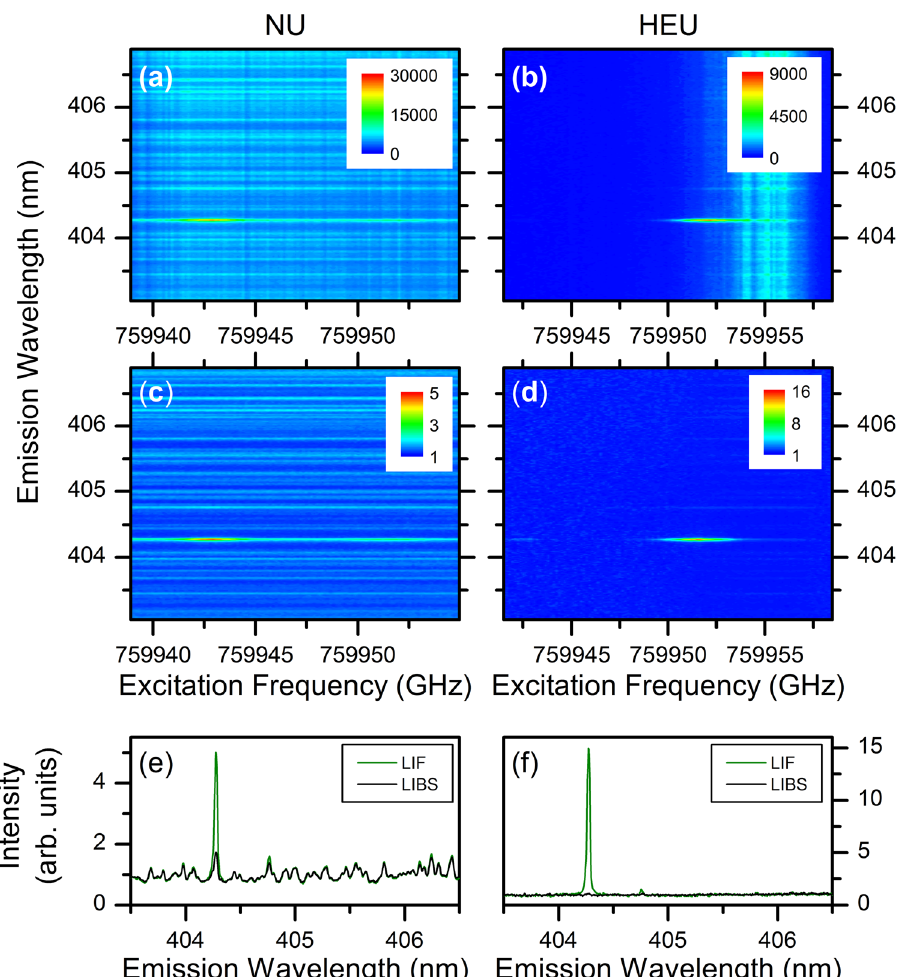
Figure 1. 2DFS images for fs laser ablation of the uranium samples. 2DFS of NU (left) and HEU (right) in 50 Torr Ar. ( a , b ) Raw 2DFS showing counts detected by ICCD (color-map) as a function of emission wavelength (y-axis) and ECDL excitation frequency (x-axis). ( c , d ) 2DFS normalized to total emission intensity at each ECDL frequency step. ( e , f ) Normalized emission spectrum with ECDL on-resonance with 238 U I and 235 U I 394.38 nm absorption (LIF) and off-resonance